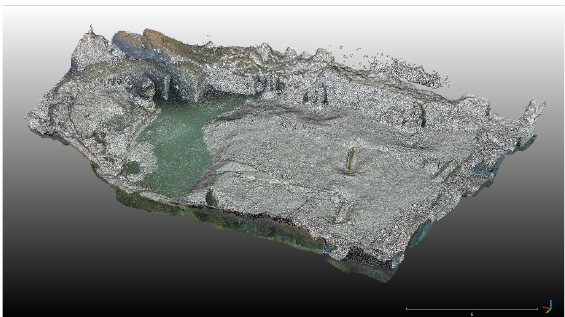
Figure 8. Overlapped 3D models of the site before and after dredging: in white the sand that covered the archaeological